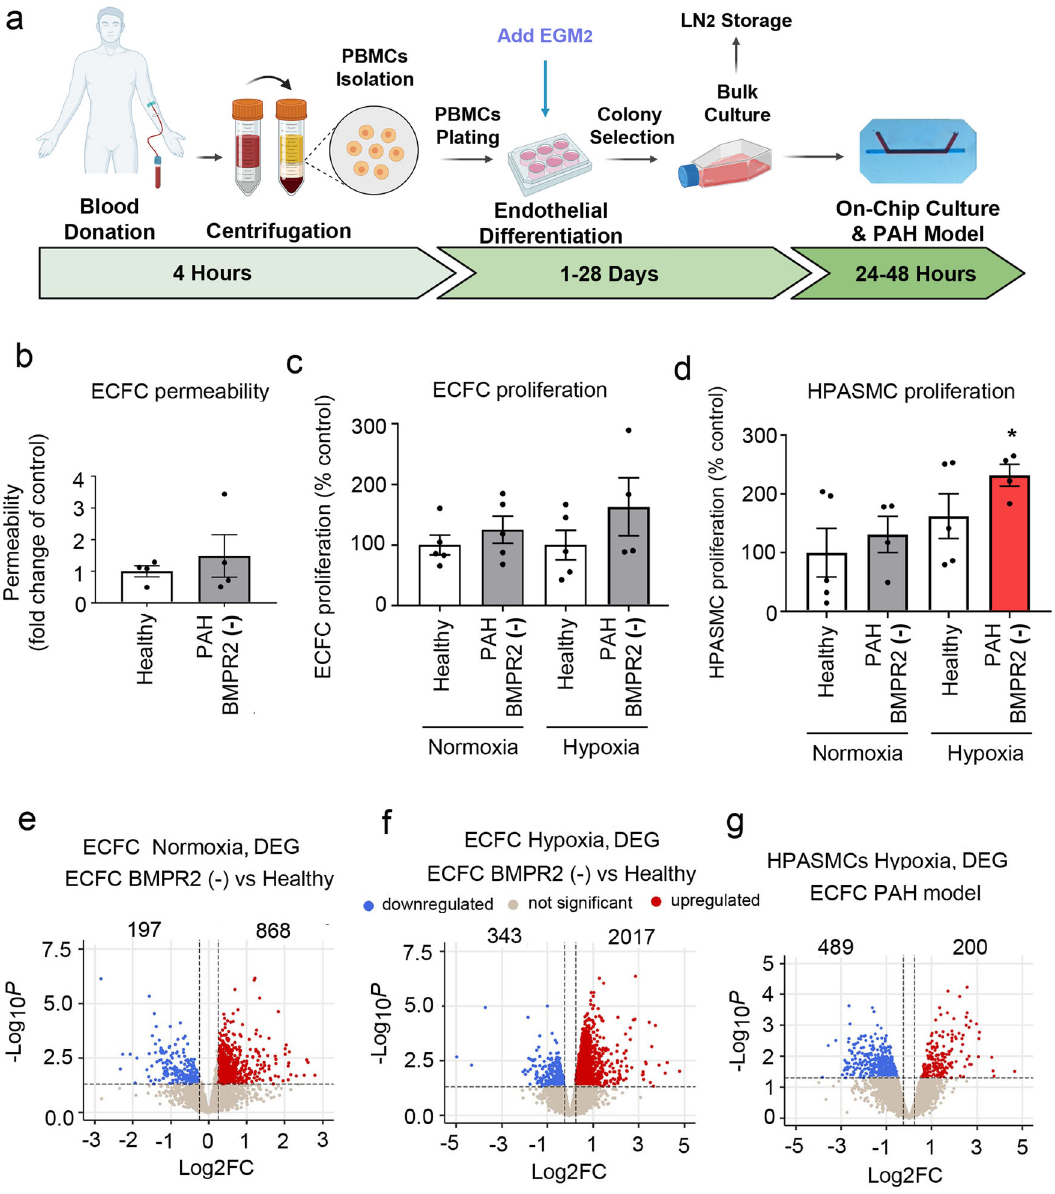
Fig. 4 Model validation using cells from PAH patients with BMPR2 mutations. a Schematic diagram of isolation and culture of patient ECFCs. b Permeability of ECFCs from healthy individuals and PAH patients with BMPR2 mutations cultured in PA-on-a-chip. c Proliferation of healthy and PAH ECFCs in PA-on-a-chip under normoxic or hypoxic conditions (2% O 2 , 24 h), as indicated. d Proliferation of HPASMCs co-cultured with control or patient ECFCs under normoxic or hypoxic conditions. n = 4 – 5 biological donors, each assayed in a separate chip. Bars are means ± SEM; one-way ANOVA with a Tukey post-test; * p ≤ 0.05. Volcano plots show e DEG in PAH ECFCs with BMPR2 mutations vs. healthy controls in normoxia, f DEG in PAH ECFCs vs. healthy controls in hypoxia (ECFC PAH model), g DEG in HPASMCs in hypoxia. In e – g n = 5 biological donors, each in a separate